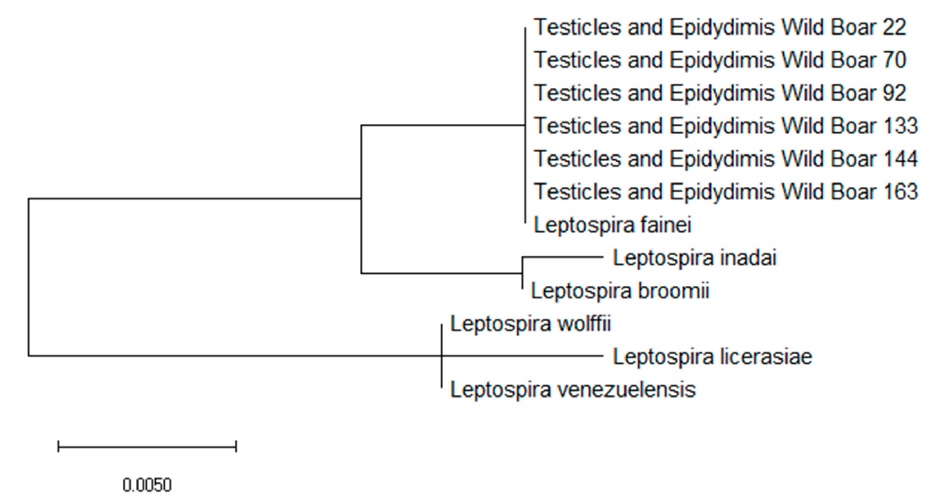
Leptospira broomii , Leptospira wolfii , Leptospira licerasiae , and Leptospira venezuelensis by the maximum likelihood method based on the Tamura–Nei model. The branch lengths of the tree measures the Figure 1. Molecular phylogenetic analysis for the 16s rRNA gene of Leptospira fainei , Leptospira in- number of substitutions per site. The analysis involved 22 nucleotide sequences. There was a total of 438 positions in the final